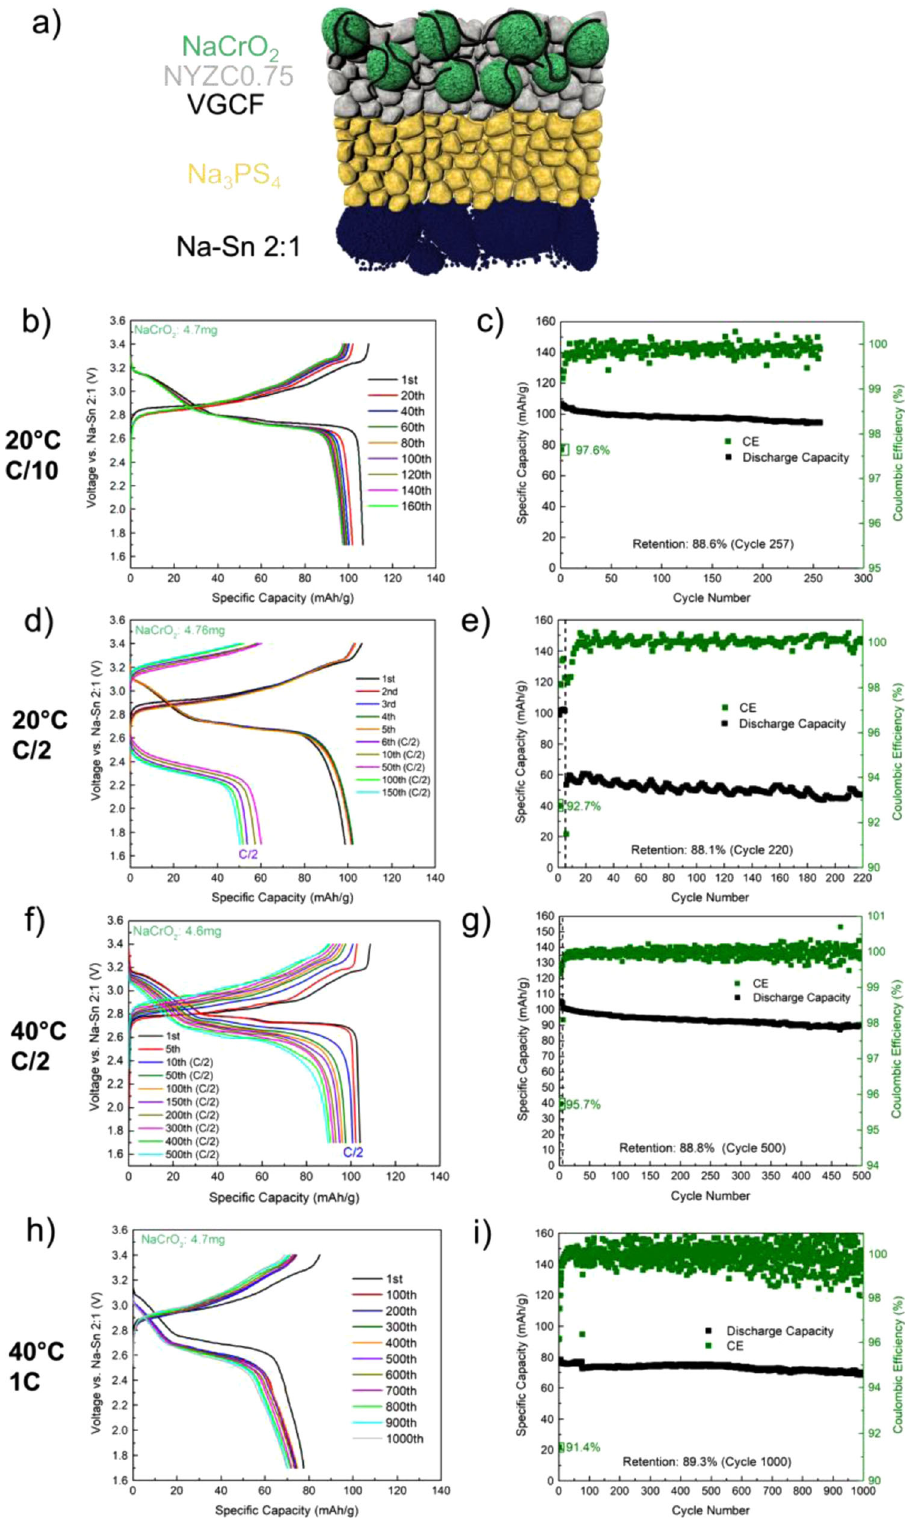
Fig. 5 Electrochemical performance of the NYZC0.75 SSSBs. a Cell schematic. Voltage pro fi le and speci fi c capacity as a function of cycle number of this cell con fi guration, respectively, running at: b – c 20 °C and C/10, d – e 20 °C and C/10 for the fi rst 5 cycles and subsequent cycling at C/2, f – g 40 °C and C/ 10 for the fi rst 5 cycles and subsequent cycling at C/2, and h – i 40 °C and 1 C. In each case, the NYZC0.75 cells exhibit long-term cycling stability, with 89.3% capacity retention at 1000 cycles for the 40 °C 1 C